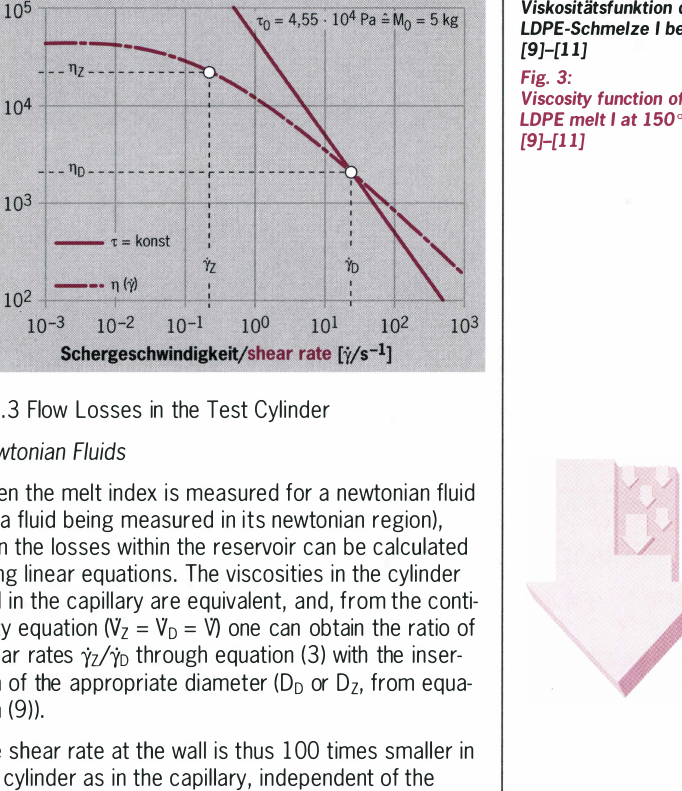
Fig. 3: Viscosity function